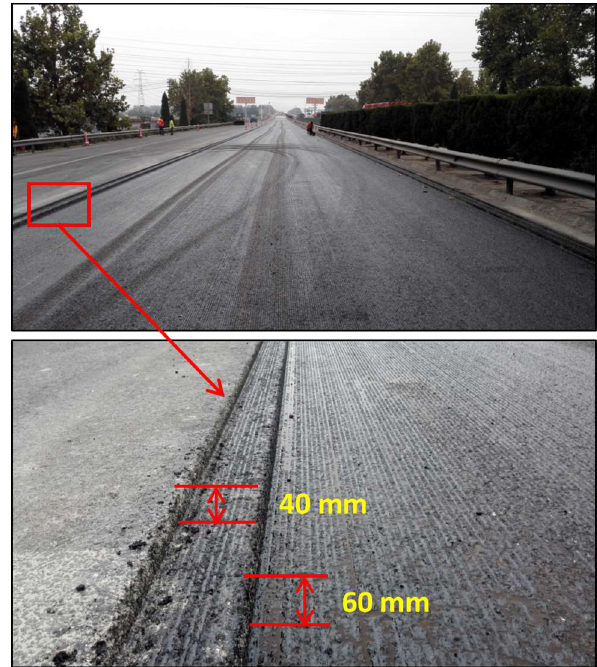
Figure 4. Treatment of underlayer surface with emulsified bitumen to ensure good bonding with the middle layer.